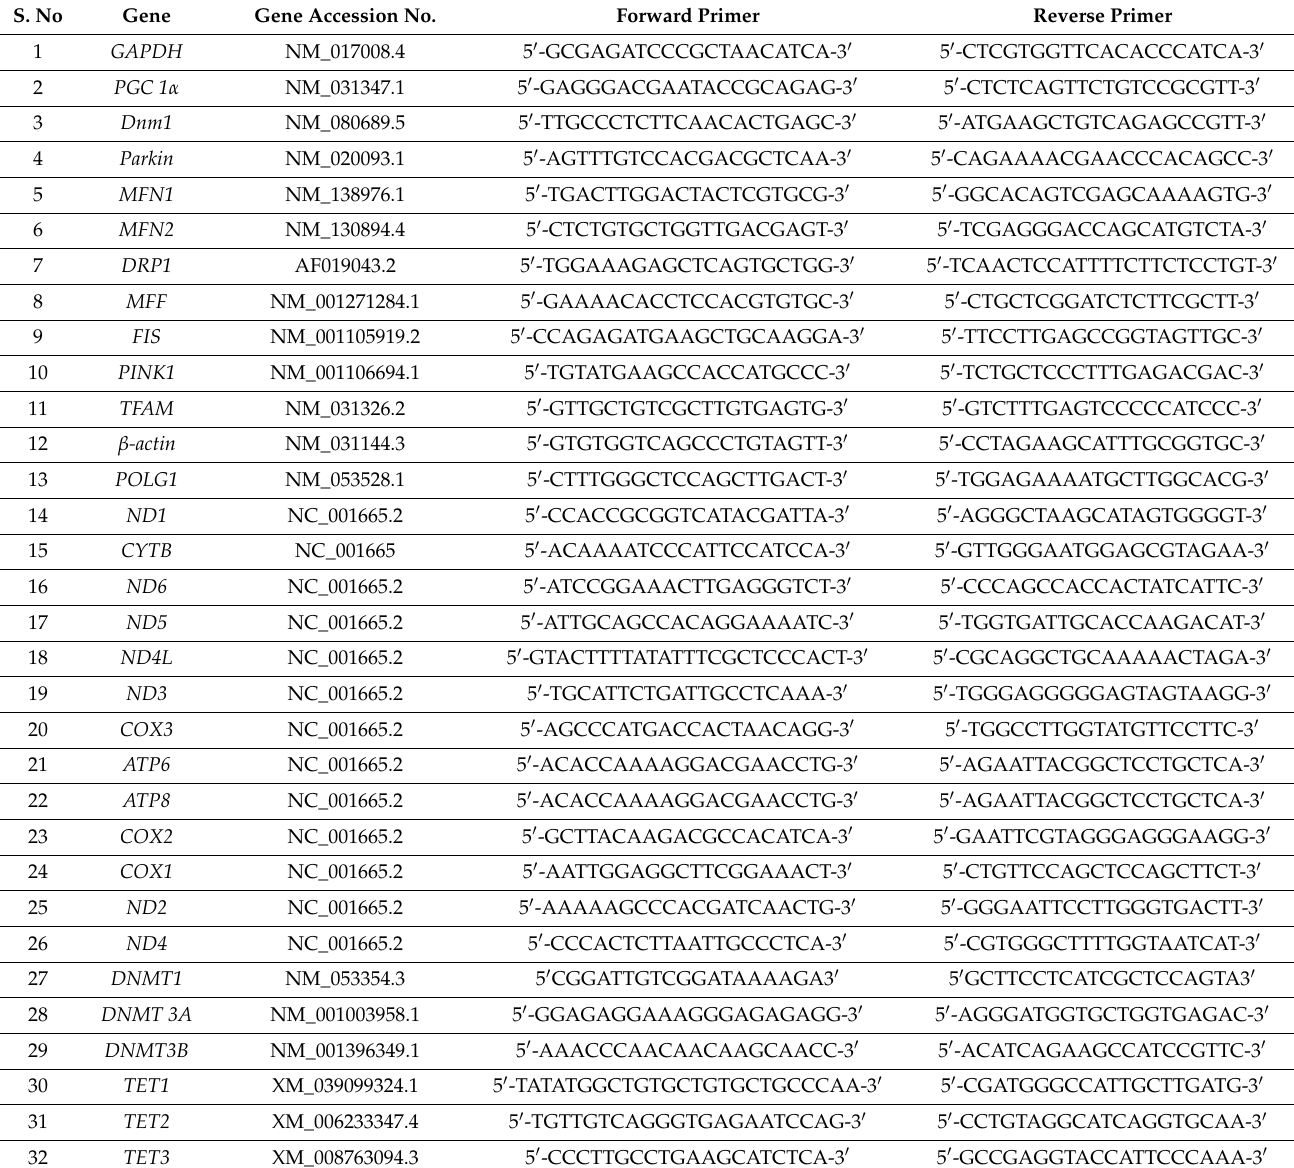
Table 1. Primer sequence details: The forward and reverse primer sequences of the genes used for real-time PCR analysis are